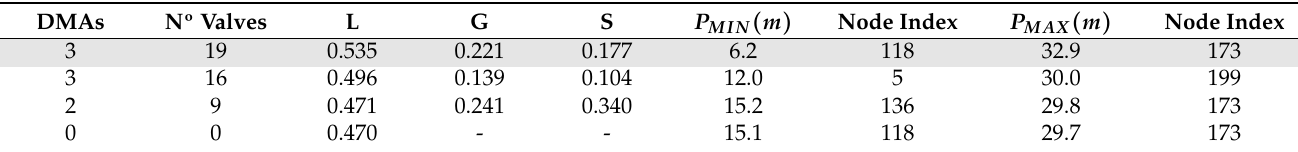
Table 3. Operating conditions of each solution obtained with Loss of resilience for TRN network. The gray background corresponds to the solution C represented in Figure 6.